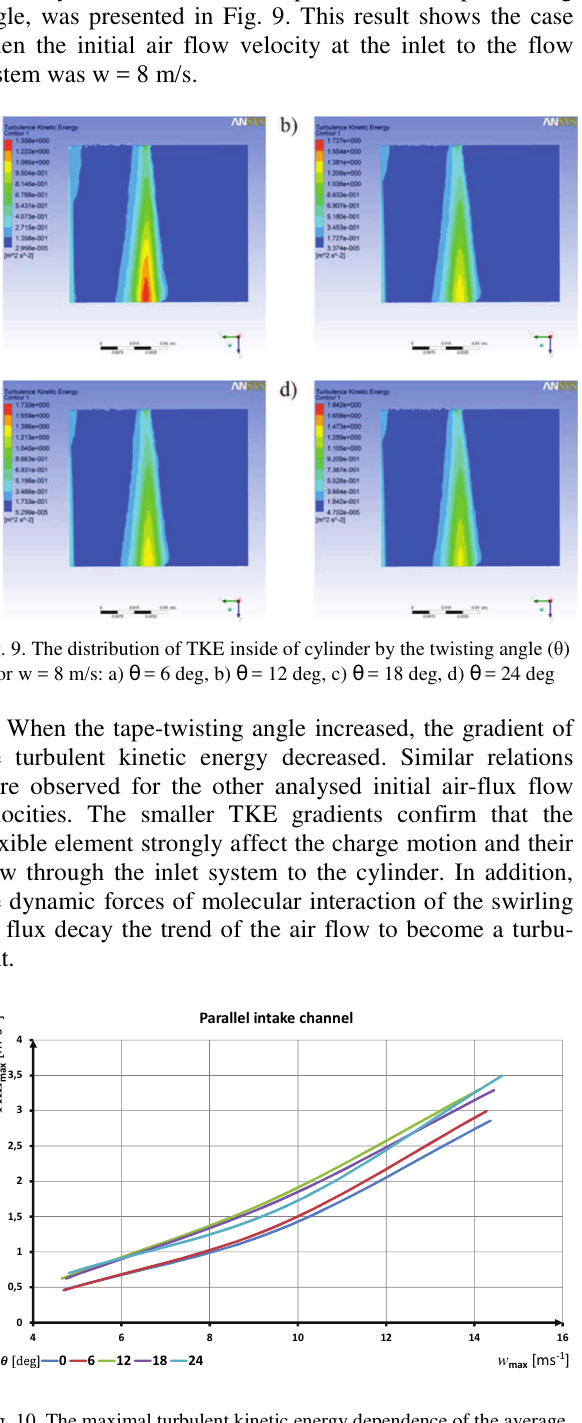
Fig. 10. The maximal turbulent kinetic energy dependence of the average air flow velocity w and an angle of twisting tape These interactions stabilise the air flux flow. The flow stability does not help to prepare the optimal air-fuel mix- ture because air turbulence mixes the air and the level of fuel drops. Moreover, the airflow turbulences decrease of diameter of the fuel drops and significantly effect on a fuel vaporisation. Thus, the air turbulence should appear where the mixture forms and during combustion, but it should not cause flame dissipation. As it was shown in Fig. 10, the